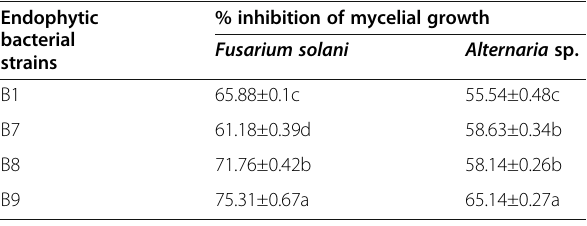
Table 1 In vitro antagonistic activity of endophytic bacterial isolates against Fusarium solani and Alternaria